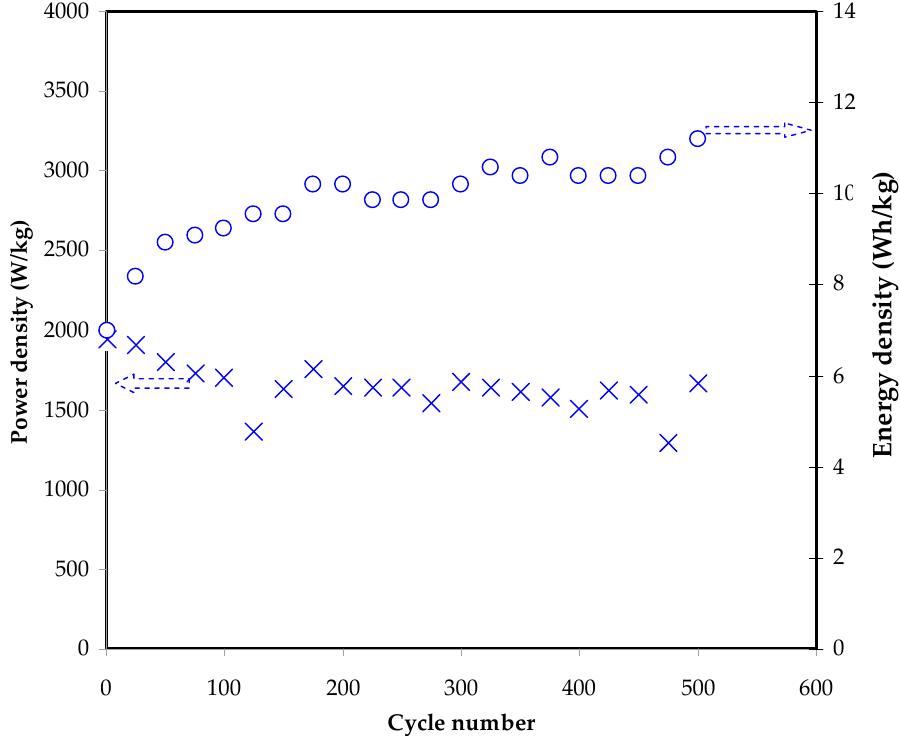
Figure 11 . The plot of E and P of the EDLC versus the cycle number at 0.5 mA/cm 2 Figure 11. The plot of E and P of the EDLC versus the cycle number at 0.5 mA/cm 2